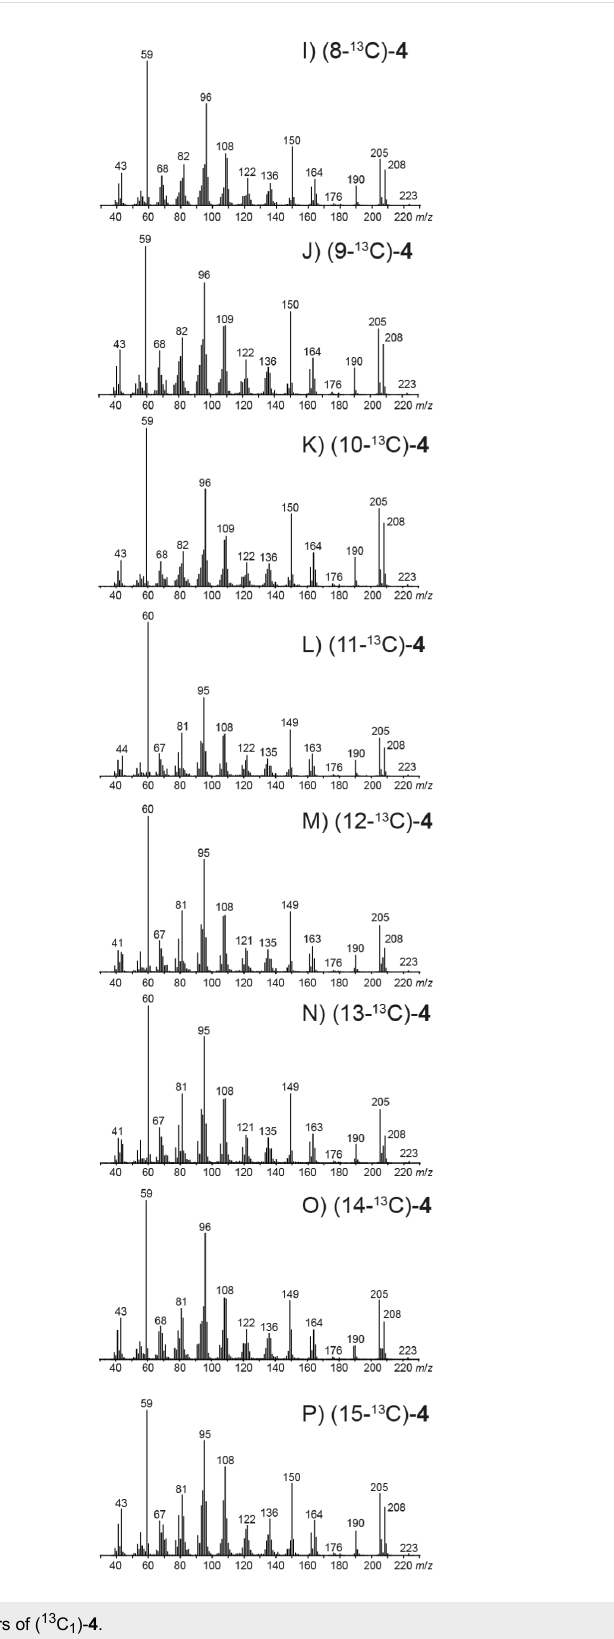
Figure 4: Mass spectra of unlabelled 4 and all fifteen positional isomers of ( 13 C 1 )- 4